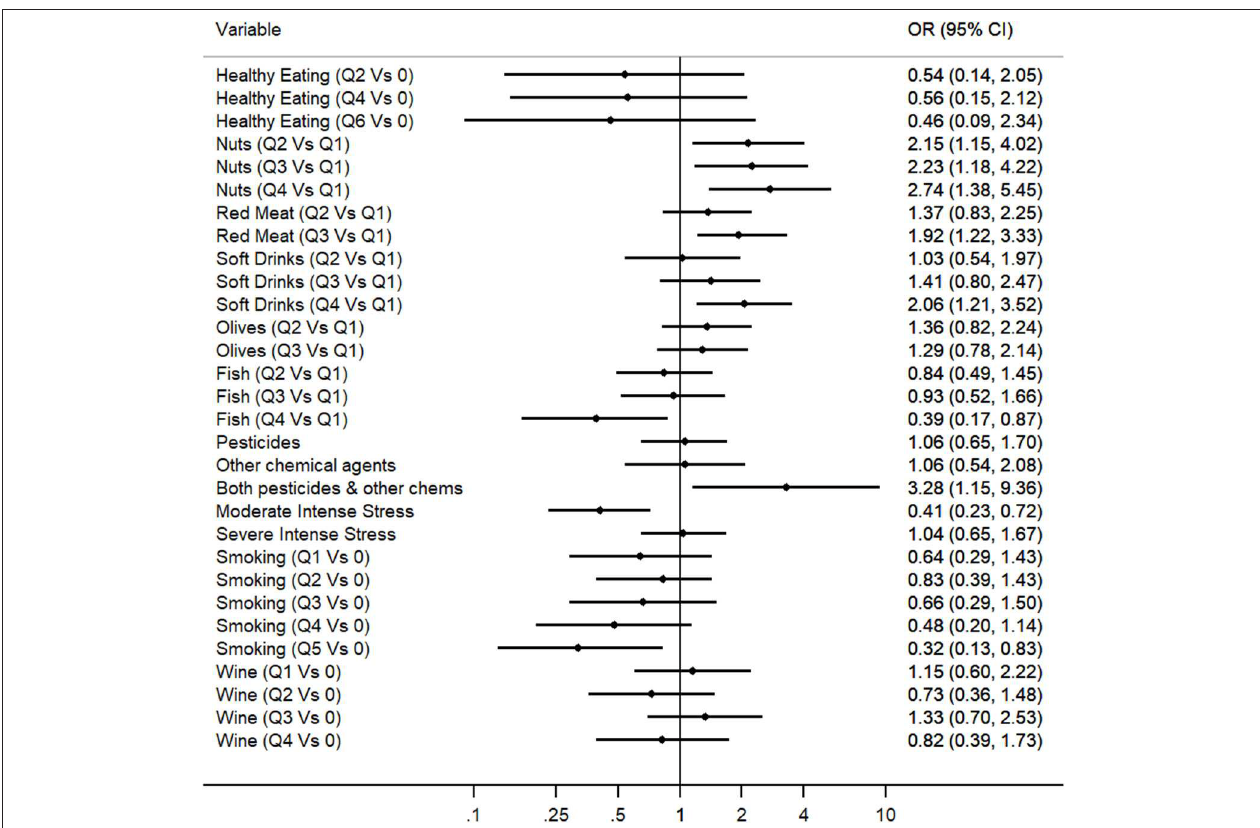
FIGURE 1 | Multivariate logistic regression analysis for the evaluation of the association between environmental factors and PD (OR and 95%CI are represented for each environmental factor).